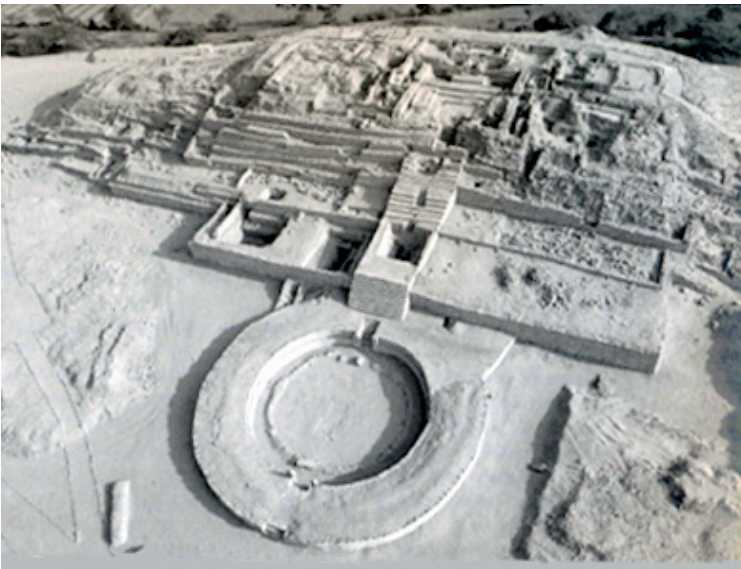
Figure 5. Caral Major Pyramid (Huaca Mejor)—location presented in Figure 3.